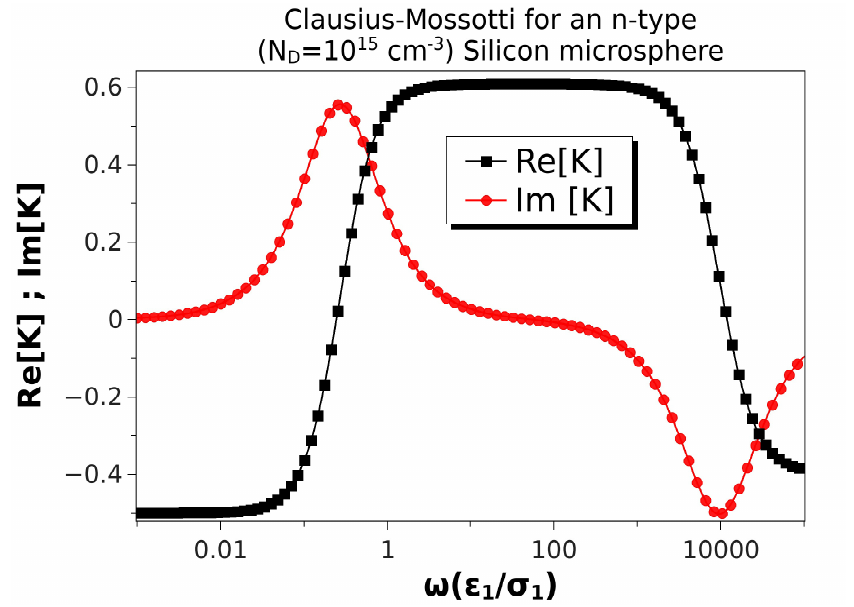
Figure 4. Real and imaginary parts of the Clausius–Mossotti factor versus nondimensional frequency for an n-type silicon microsphere immersed in a KCl solution. Particle conductivity is 22.6S/m, and the Debye length is λ D 2 = 0.331 µ m. The microsphere is 10 µ m in diameter. Thus, the nondimensional Debye length is ¯ λ D 2 =